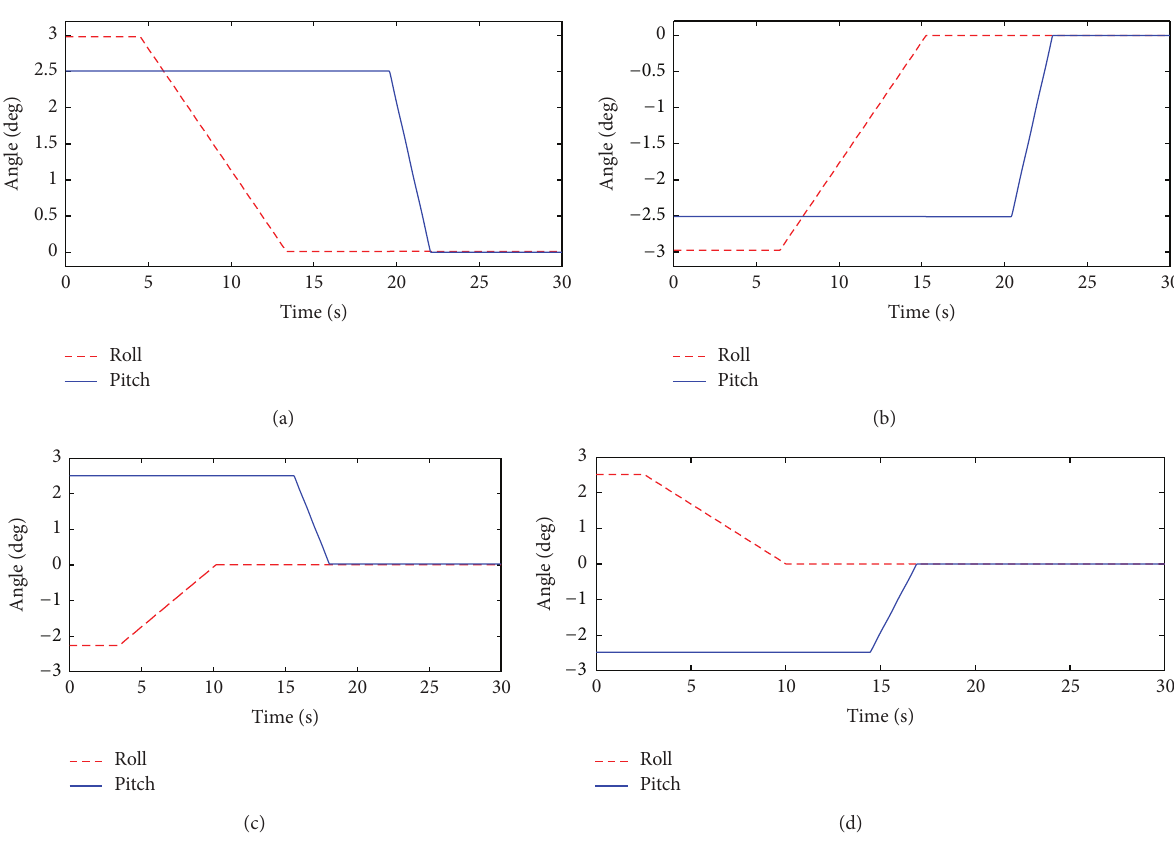
Figure 13: The leveling control with adaptive backstepping